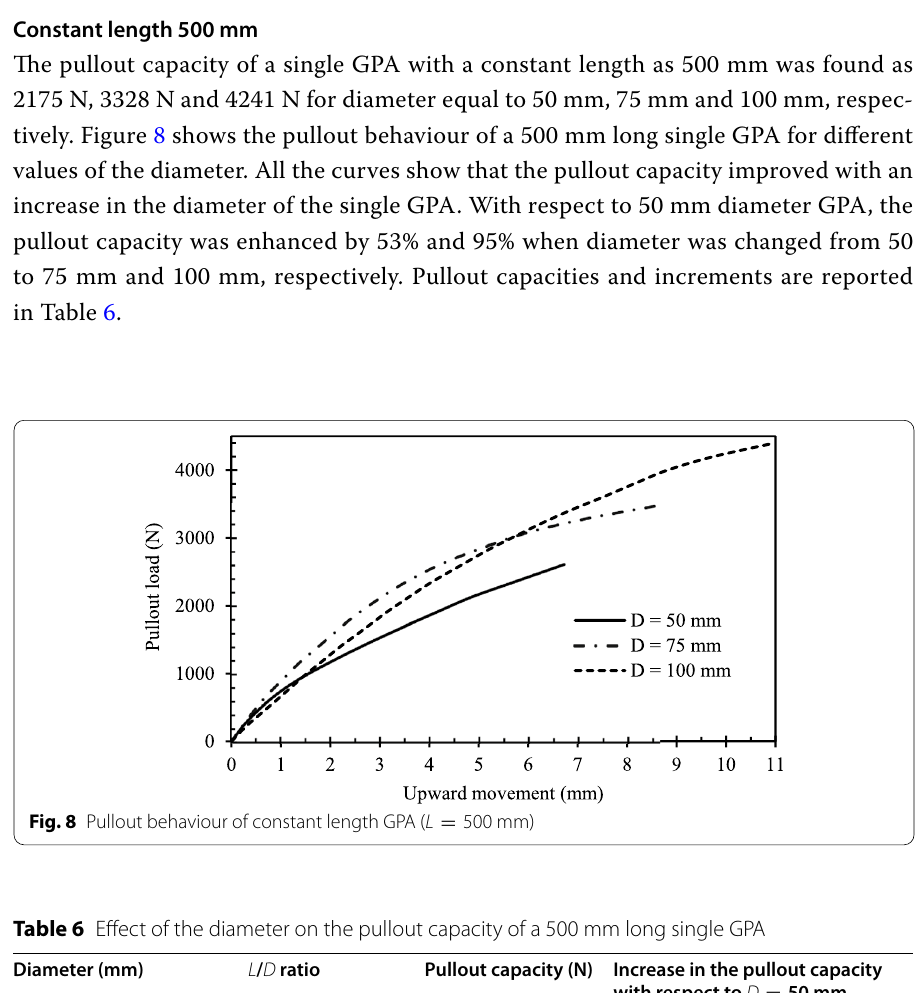
Table 6 Effect of the diameter on the pullout capacity of a 500 mm long single GPA Diameter (mm) L / D